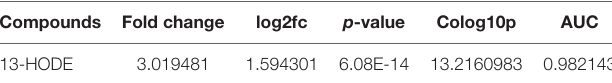
TABLE 6 | Statistically significant compounds (OX vs. LX). p -Value < 0.05 (Wilcoxon-Mann-Whitney test). Fold change ≥ 1.5 or ≤ 1/1.5. AUC (area under the curve) value of predictors selected by machine learning analysis (see Supplementary Figures 15–17 A–C and Supplementary Tables 1, 6 ).